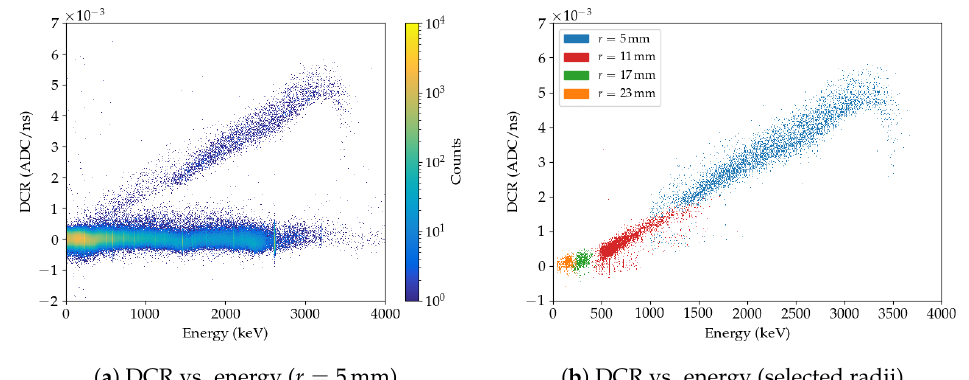
Figure 11. ( a ) Scatter plot of DCR vs energy at r = 5mm. While bulk events have DCR values centered around zero, surface alpha events have values DCR > 0. ( b ) Multivariate cuts are used to isolate surface alpha events. With increasing radius, the DCR value of surface alpha events decreases.